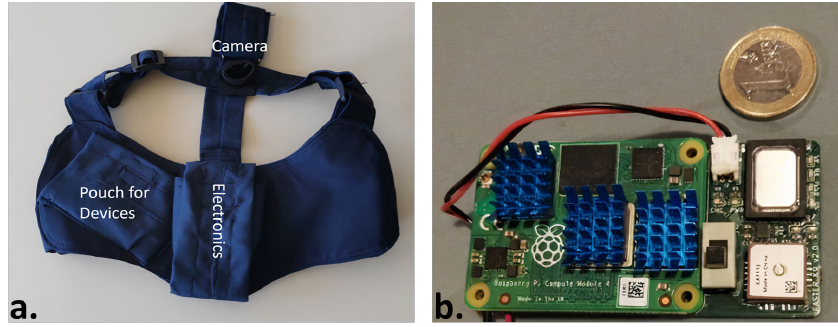
Figure 3. Designed animal harness ( a ) and electronic device ( b